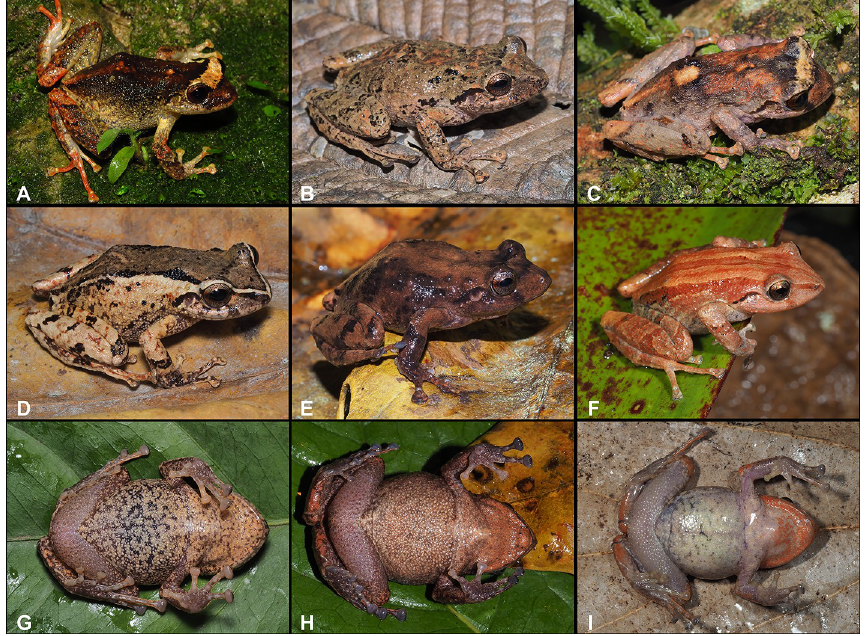
Fig 8. Color variation in females of Pristimantis lojanus sp. nov. in life. A. Not collected, Loja city, Parque Universitario de Educacio´n Ambiental y Recreacio´n “Francisco Vivar Castro”; B. Paratype, (MUTPL 176), SVL 37.8 mm, Loja city, Quebrada Volcan; C. Not collected, Cristal; D and G Paratype, (MUTPL 192), SVL 44.3 mm, Cristal; E and H Paratype, (MUTPL 177), SVL 42.1 mm, Loja city, Quebrada San Simon; F and I Paratype, (MUTPL 935), SVL 34.9 mm, Cerro Sacama; A–F Dorsolateral views; G–I Ventral views.